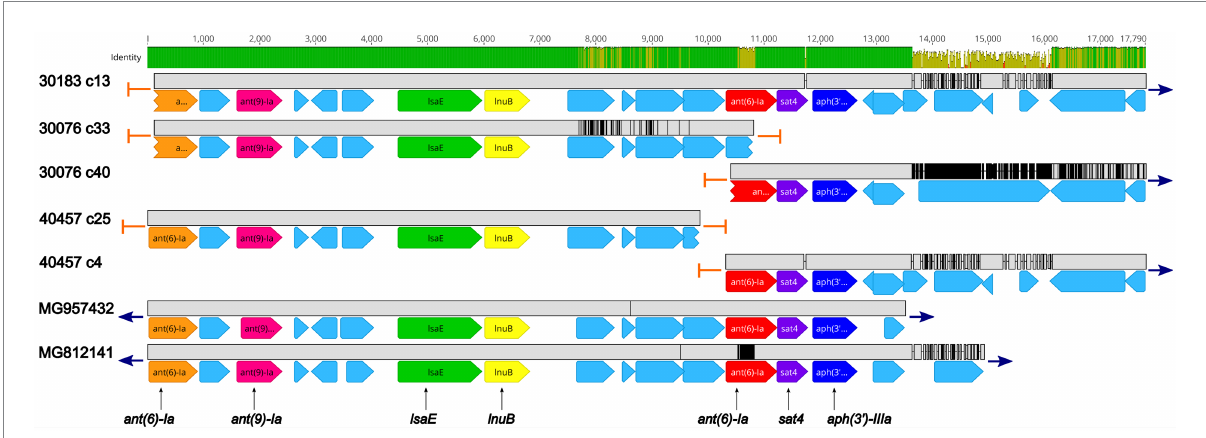
FIGURE 3 Genomic organization and alignment of the region containing the ant(6)-Ia, sat4, and aph(3 ′ )-IIIa genes. The S. suis isolate and contig number (c) for each sequence, along with the accession numbers for the Enterococcus faecium plasmid and the Erysipelothrix rhusiopathiae ICE (ICCEr0106) shown at right. Base pair numbers are displayed above black bar at top. Green and yellow shaded bar below depicts sequence identity with green indicating 100% identity and yellow indicating lower identity. Grey bar in between each aligned sequence region depicts sequence similarity between each sequence with grey indicating nucleotide positions with 100% identity. Blue arrows at end of grey bars indicate contig sequence continues and orange bars indicate end of contig sequence. AMR gene elements are listed below and are indicated by orange ( ant(6)-Ia ), pink ( ant(9)-Ia ), green ( lsaE ), yellow ( lnuB ), red ( ant(6)-Ia ), purple ( sat4 ), and dark blue ( aph(3 ′ )-IIIa ). All other CDSs are indicated by light blue. Predicted incomplete CDSs are indicated by jagged ends. Accession number MG957432 is a complete nucleotide sequence from Enterococcus faecium strain 37BA conjugative plasmid (pEf37BA) isolated from a human. Accession number MG812141 is a complete nucleotide sequence from Erysipelothrix rhusiopathiae ICE (ICCEr0106).